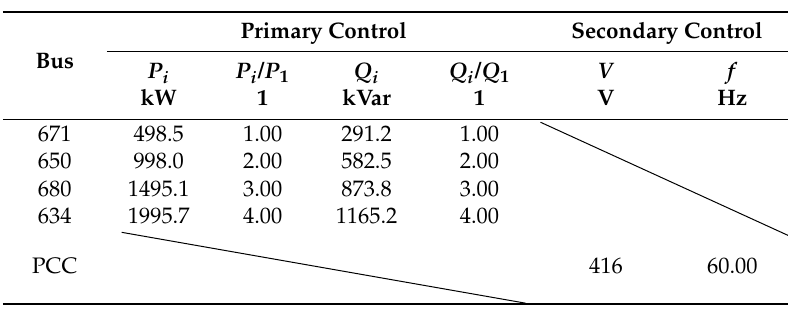
Table 7. Summary of Simulation Results in Scenario